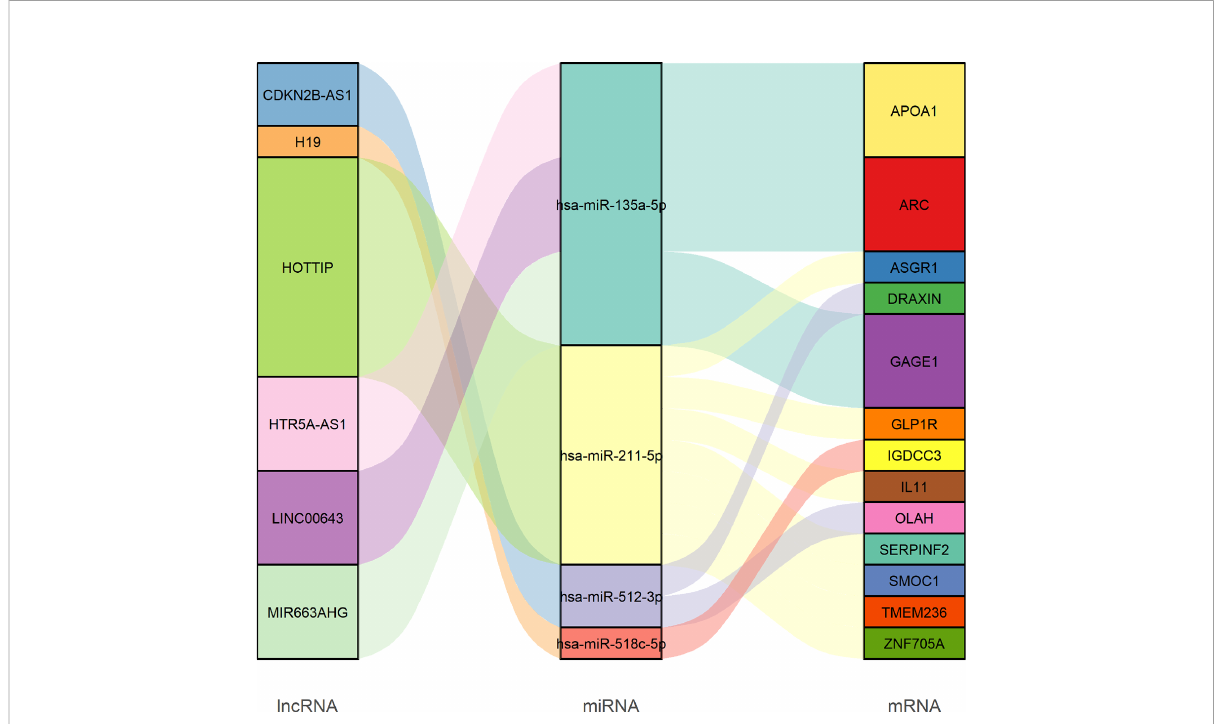
FIGURE 8 Sankey diagram of the competing endogenous RNA network in GC. Each rectangle represents a gene, and the connectedness of each gene is shown according to the size of the